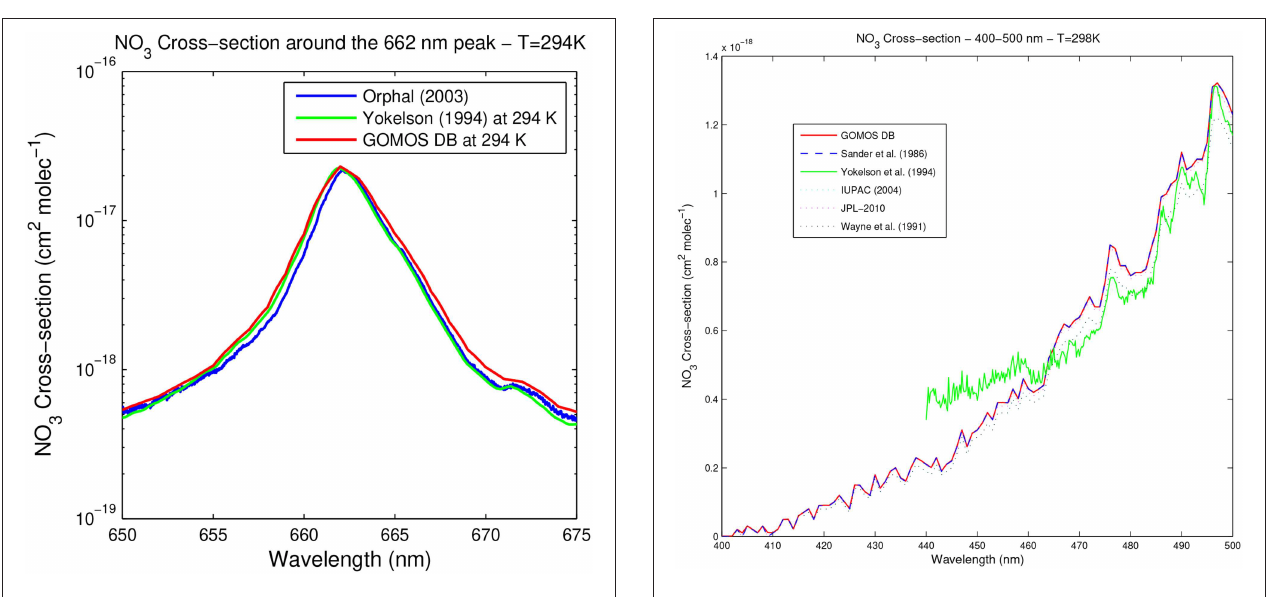
available at 4 different temperatures with a resolution of 0.2 nm, higher than the one of the GOMOS SPA down to 440 nm. The other considered datasets are given with a lower sampling rate of 1 nm, and are thus not selected for the revision of the GOMOS cross-section database in this spectral